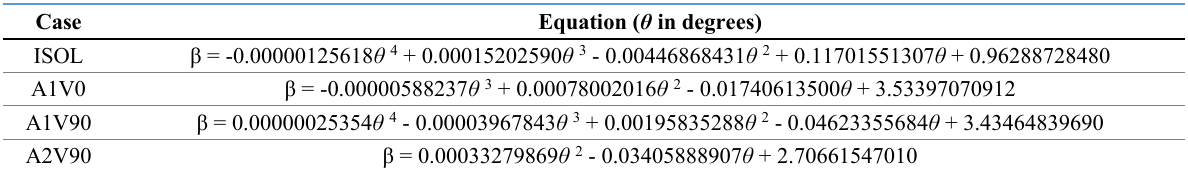
Table 5. Equations of β for displacement at the top, x-direction – limit criterion of H/1370.